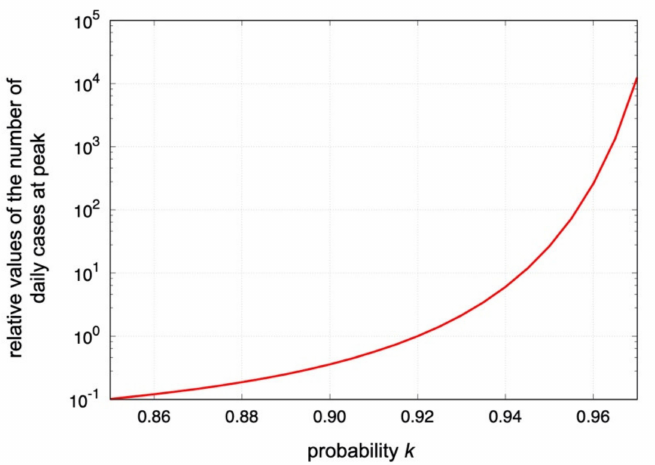
Figure 5. The predicted k dependence of the relative values of the number of daily confirmed cases at peak positions in the logarithmic scale. The relative value is normalized at k = 0.92, which was obtained in the 1st epidemic surge in April 2020 in Japan [19]. The value is proportional